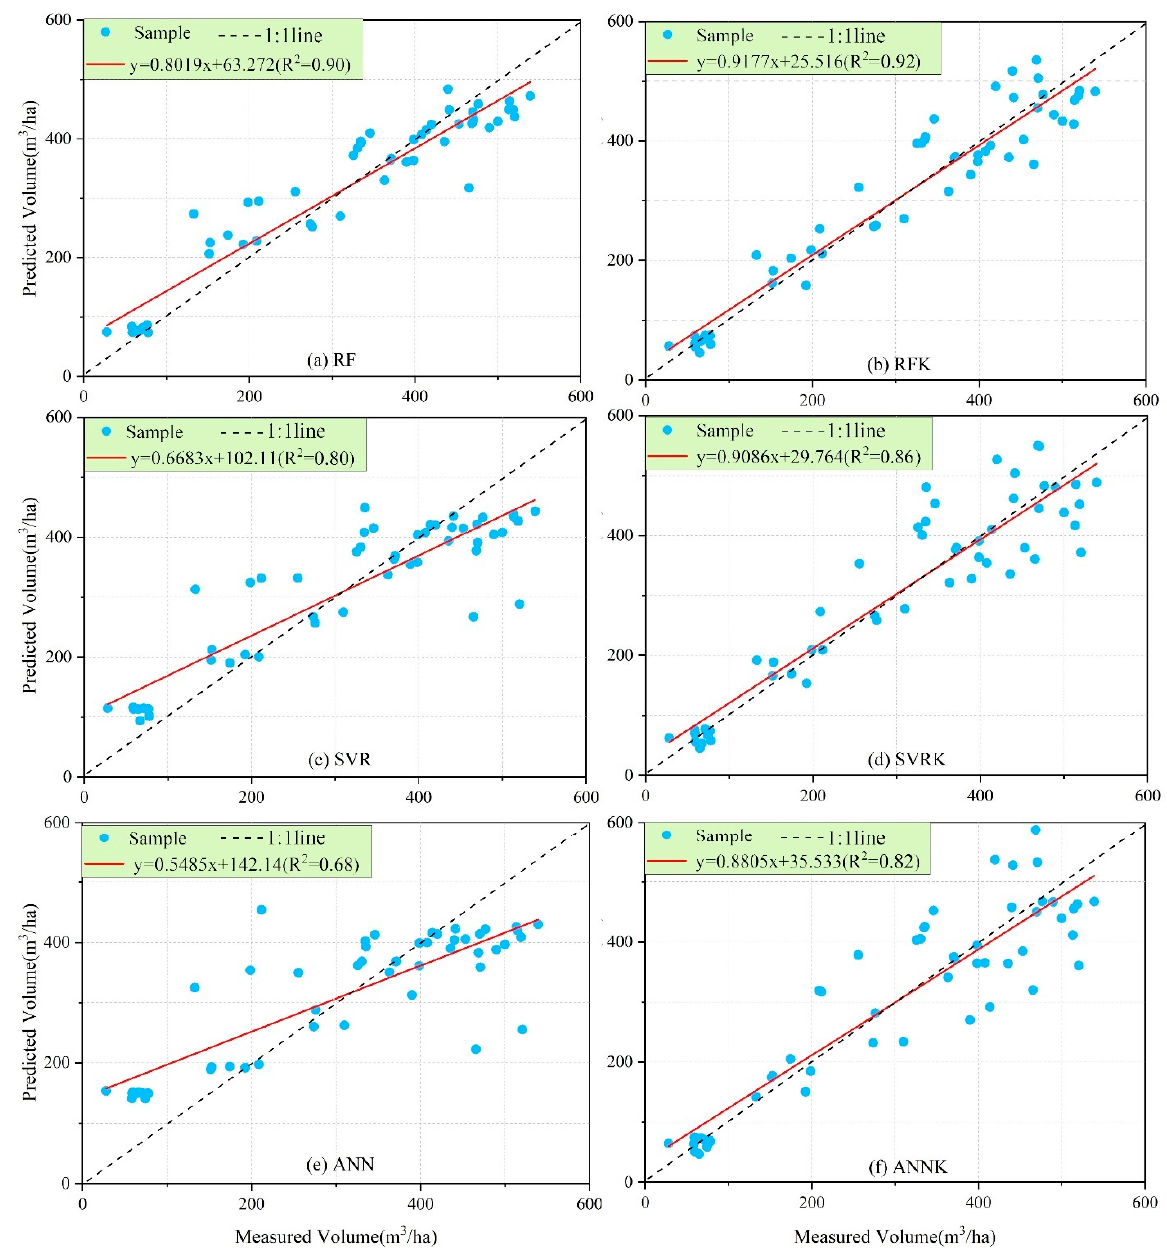
Figure 12. Scatter plot of the estimated and measured values of the six models ( R 2 = R 2 ). The above six models were compared in order to analyze the accuracy of model predictions by establishing a linear relationship between measured and predicted volume values.